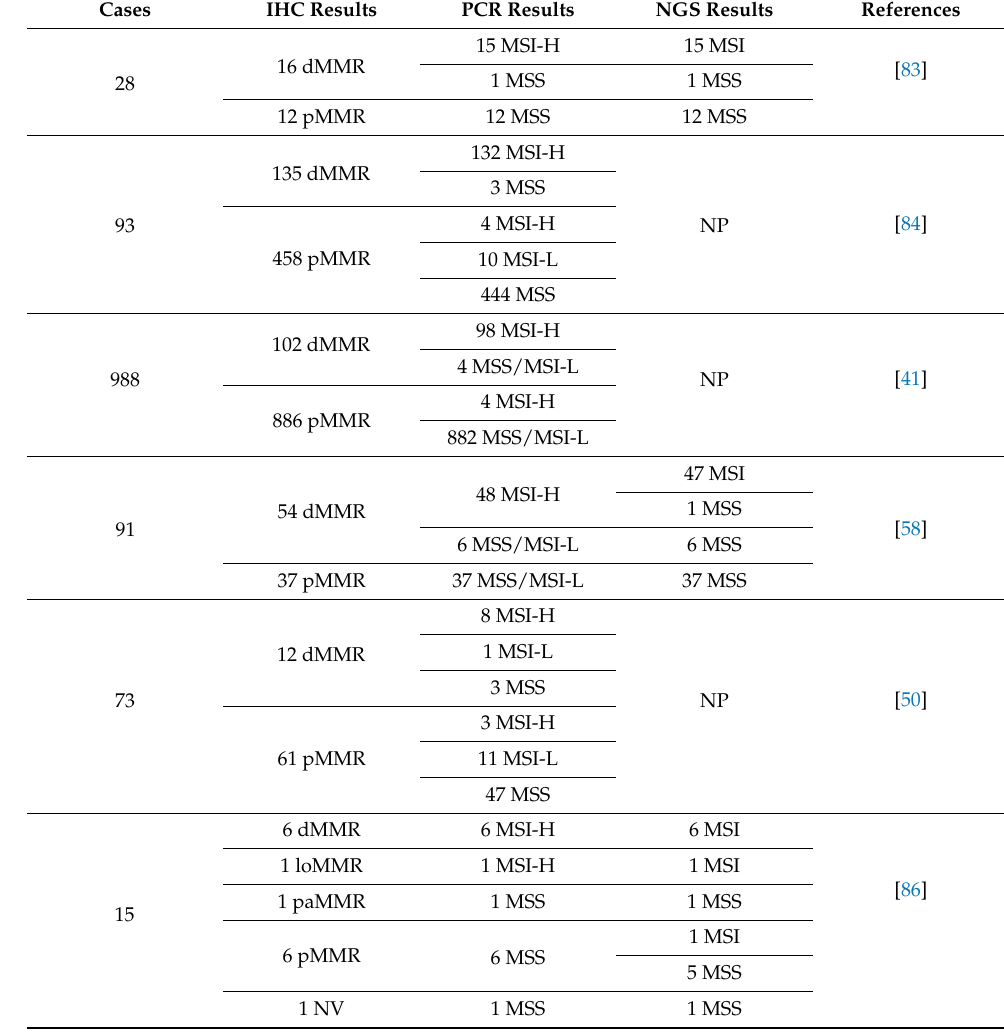
Table 2. Comparison between IHC, PCR and NGS in CRC